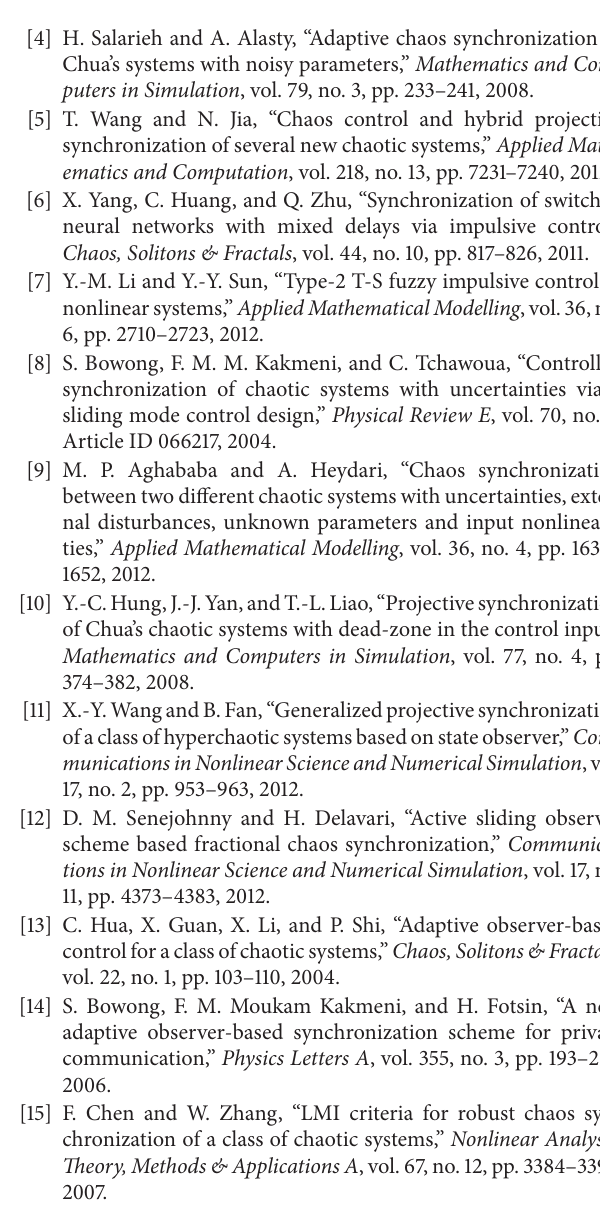
respectively. The initial values of the drive system and the 𝑇 = (0.1 0.2 response system are ( 𝑥 1 (0) 𝑥 2 (0) 𝑥 3 (0) 𝑧(0) ) (0) ̂𝑥 (0) ̂𝑥 (0) ̂𝑧(0)) 𝑇 =(−4 2.5 1 −0.3) 𝑇 0.2 0.8) 𝑇 and (̂𝑥 1 2 3